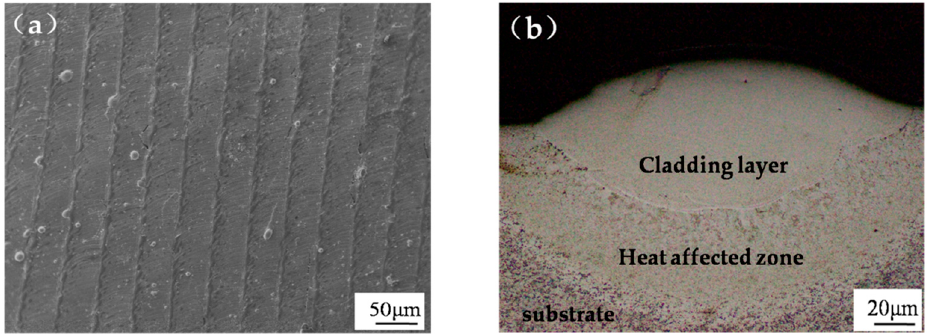
Figure 2. Micro-morphologies of the AlCoCrFeNiTi 0.5 HEA (High-entropy alloy) coating for ( a ) surface and ( b ) cross-section single-track